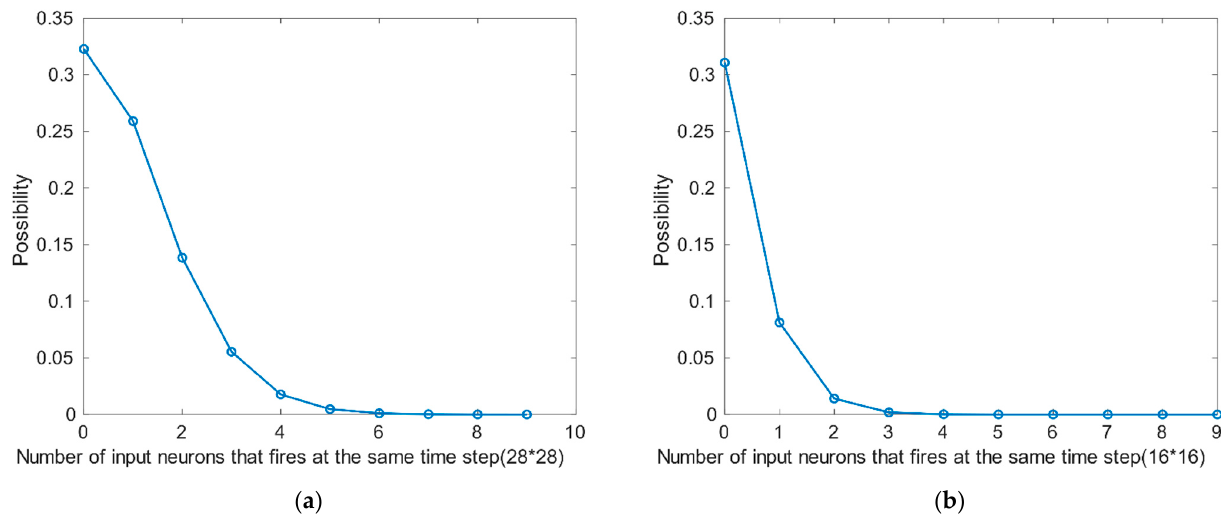
Figure 3. Probability distribution of the number of input neurons that fire at the same time under different input resolutions using 1-bit fixed frequency coding. ( a ) Under full resolution (input neurons = 28 × 28), ( b ) under low resolution (input neurons = 16 × 16).